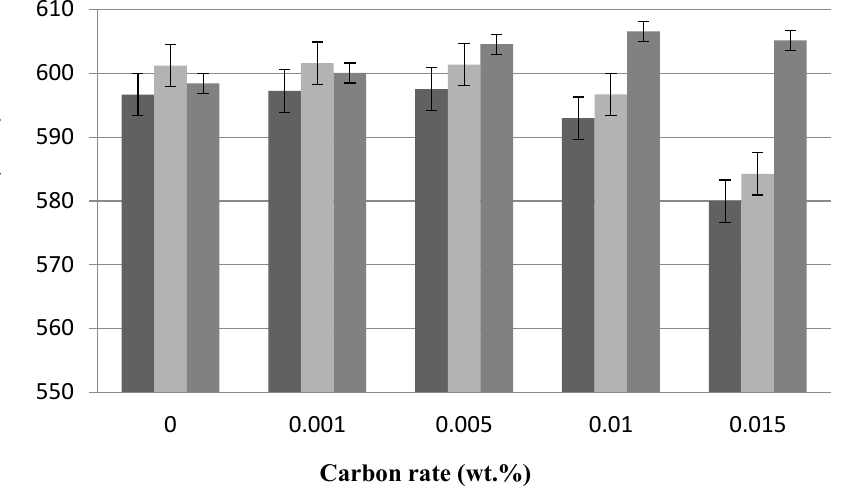
Figure 3. Effect of C rate to UTS of Al-Zn-Mg-Cu